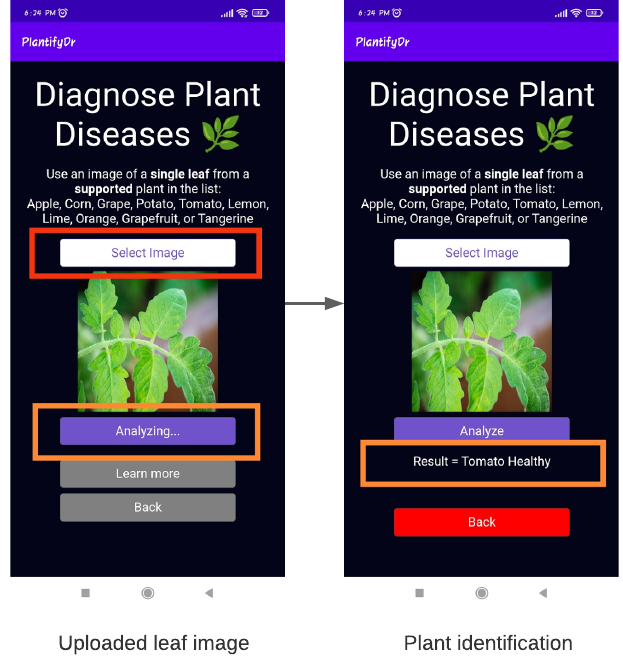
Figure 4. Plant identification by PlantifyDr